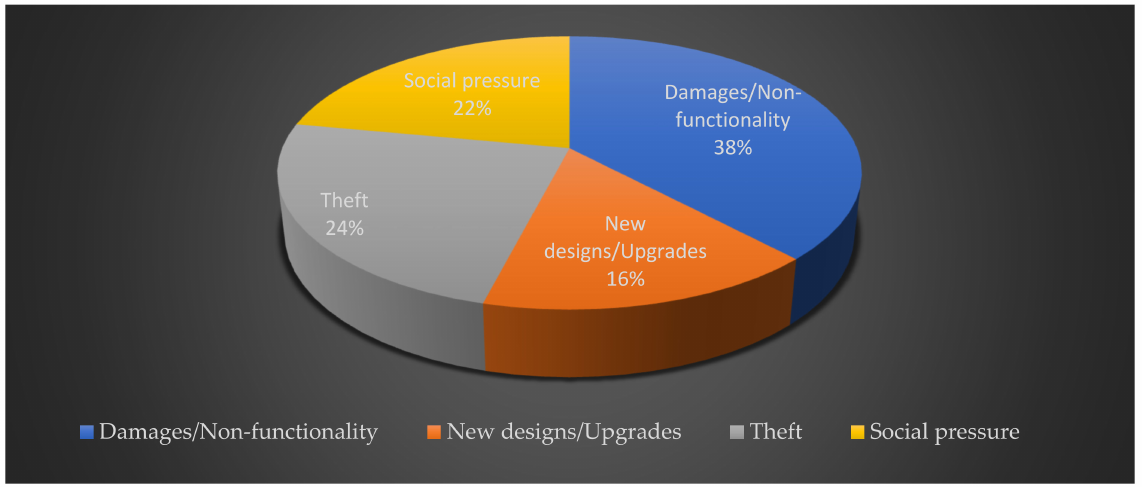
Figure 4. Respondents’ reasons for changing electronic devices.